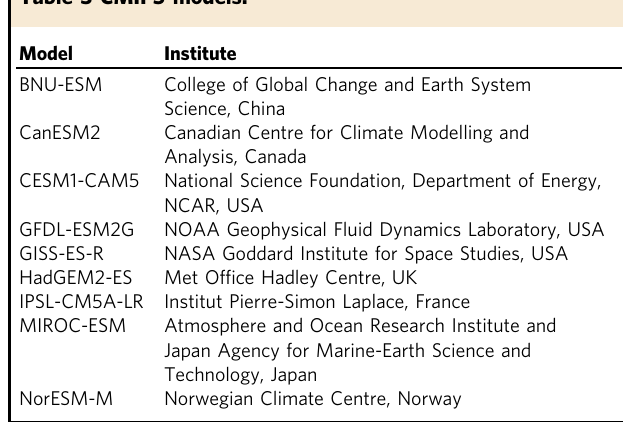
Fig. 4 Emergent constraint on Δ C s, τ as a function of global warming. a Actual vs. estimated scatter plot for Δ C s, τ for 2 °C of global warming. The vertical green line de fi nes the observational constraint which is derived using observational data and the future spatial temperature fi eld of each model (decadal average), and the shaded region represents the corresponding uncertainty (±1 standard deviation). The horizontal blue line represents our emergent constraint, with the shaded region showing the corresponding uncertainty (±1 standard deviation) which results from the differing future spatial warming patterns seen in the future spatial temperature fi elds across the ESMs, and the emergent relationship between the model data points (black line). b Probability density function showing the Gaussian distribution of Δ C s, τ values from the unweighted prior model ensemble (black line) and the emergent constraint (blue line). c Constrained Δ C s, τ values at different levels of global warming (blue), including the likely (±1 standard deviation) uncertainty bounds (shaded blue). Different effective global q 10 values shown for comparison; our emergent constraint is consistent with an effective q 10 ≈ 2.5 ± 0.6. Table 2 CMIP6